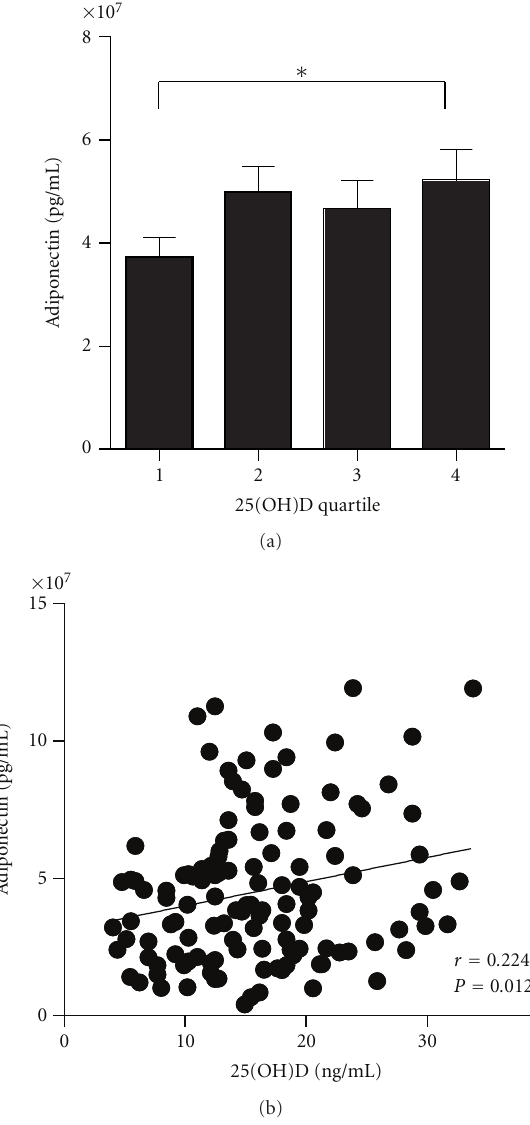
Figure 3: Serum adiponectin in levels in di ff erent quartiles (a) for serum 25(OH)D obese children (Q1: 8 . 0 ± 2 . 3; Q2: 13 . 6 ± 1 . 2; Q3:17 . 5 ± 1 . 2; Q4:25 . 3 ± 4 . 3 ng/mL). ∗ P < 0 . 05. Adiponectin concentration in relation to 25(OH)D serum levels (b) in obese